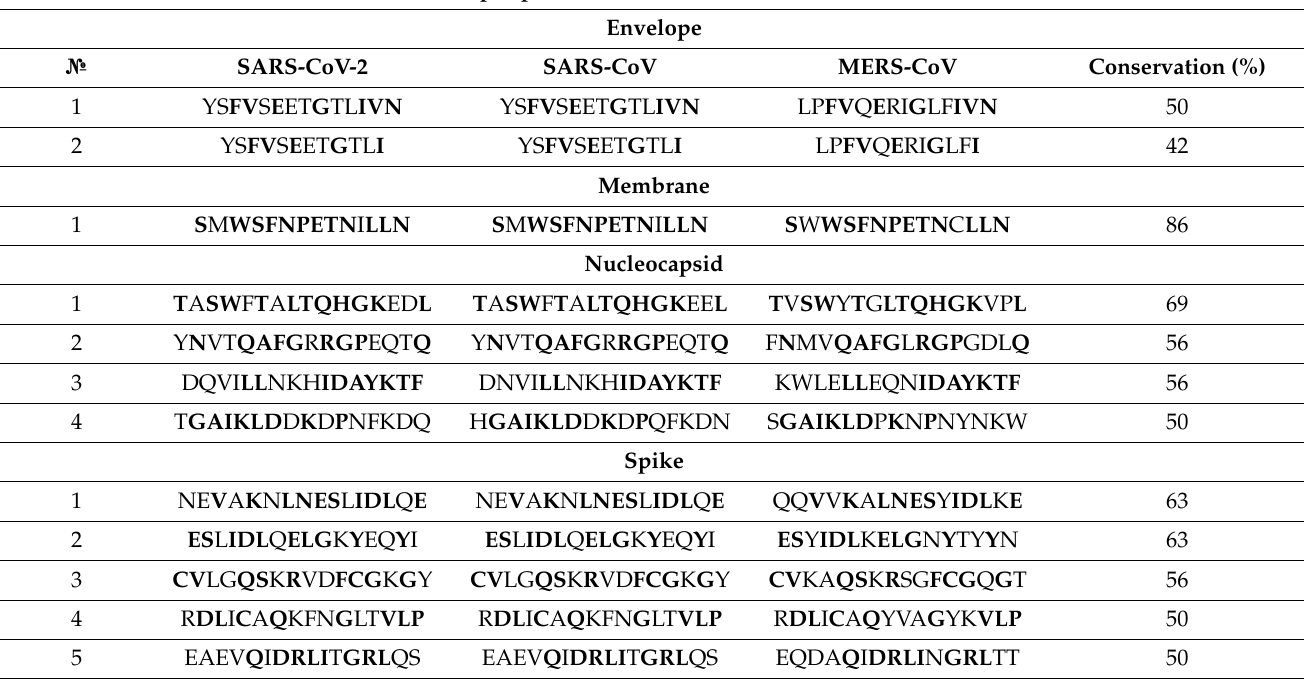
Table 4. Predicted B cell epitopes found to be conserved in E, N, M, and S protein sequences of SARS-CoV-2, SARS-CoV, and MERS-CoV. Conserved amino acids are in bold